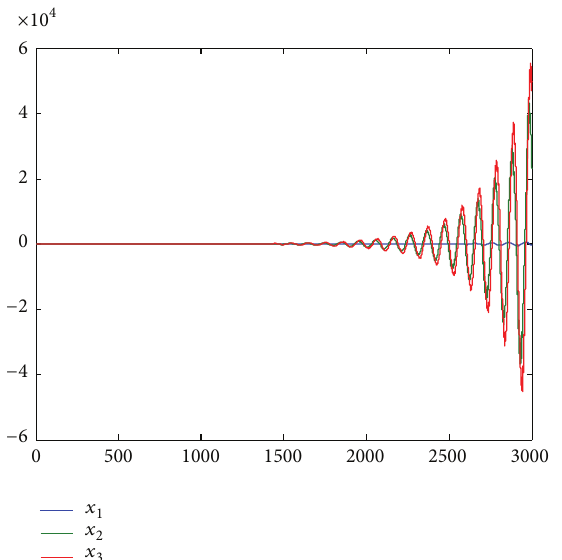
Figure 2: State responses for uncontrolled system subject to uncer- tainties and disturbance.